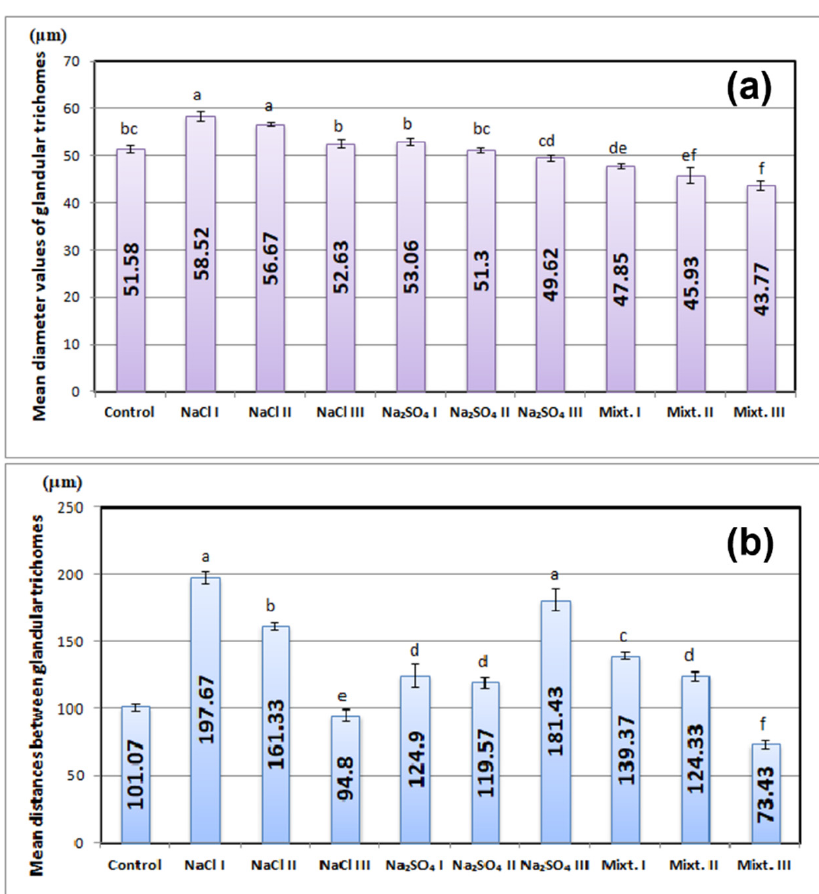
Figure 3. ESEM micro-images of the variants with the glandular trichomes indicated with arrows.